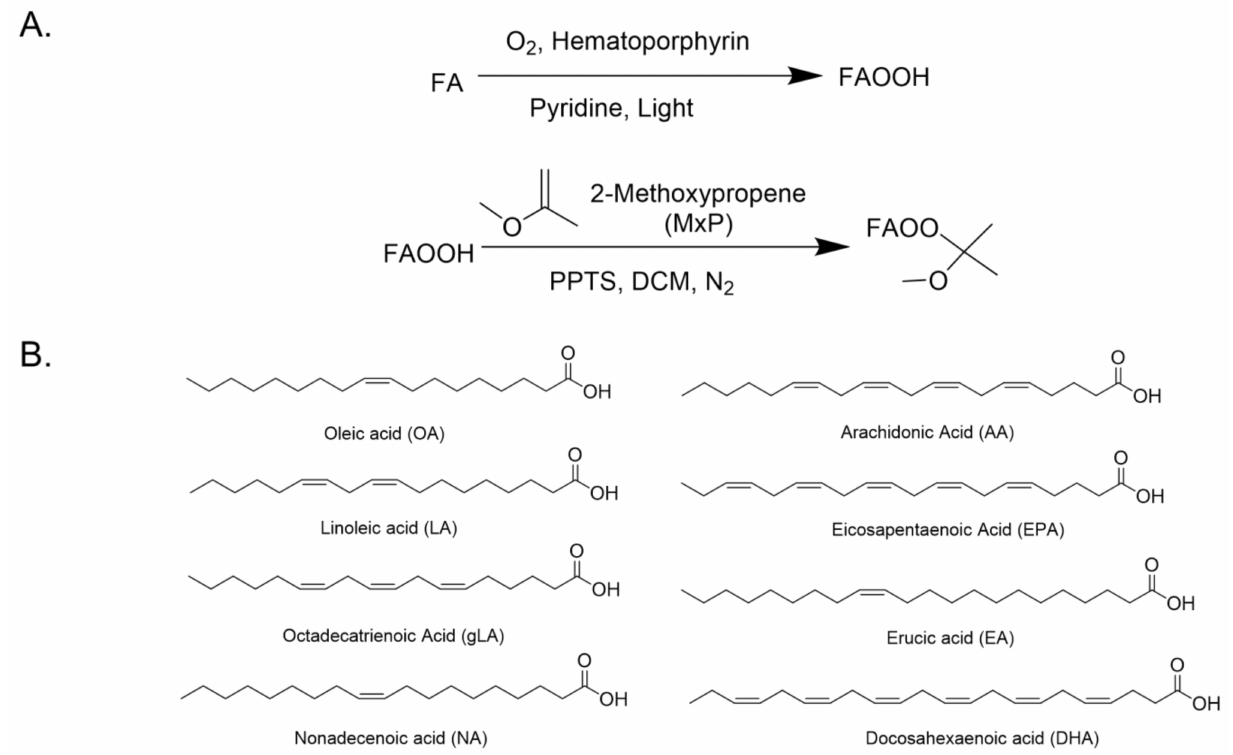
Figure 1. Synthesis of fatty acid hydroperoxides and their 2-MxP derivatives ( A ) Schematic represen- tation of the synthesis of FAOOH and FAOOMxP. ( B ) Chemical structure of unsaturated fatty acids used in the